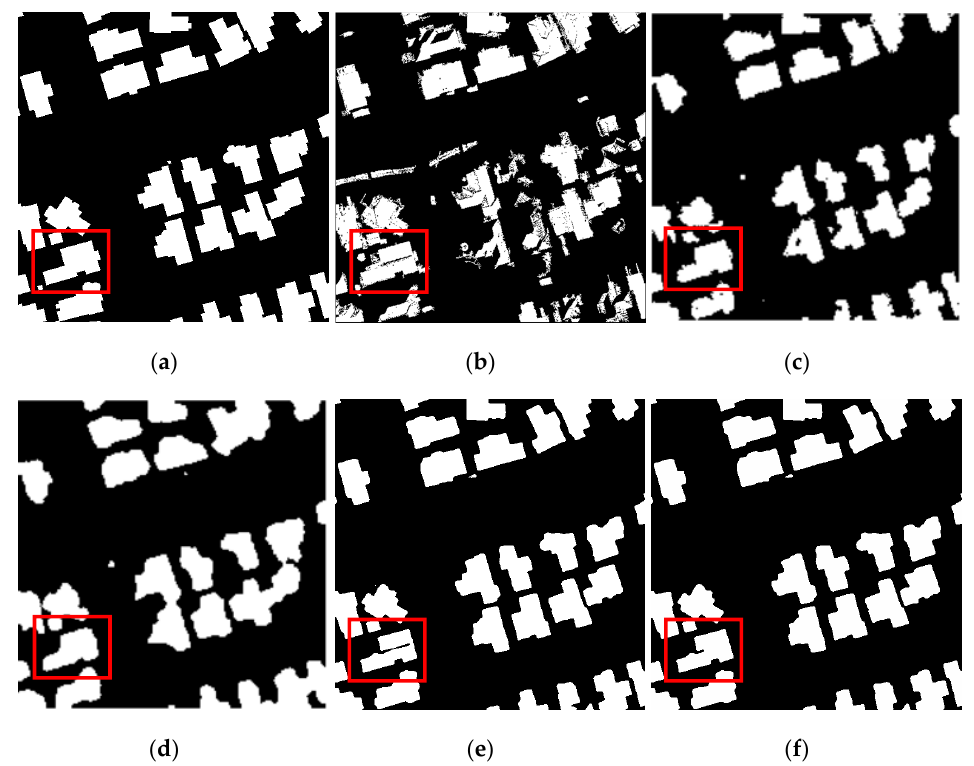
Figure 6. Original image and label. ( a ) Image 1; ( b ) Label 1; ( c ) Image 2; ( d ) Label 2.